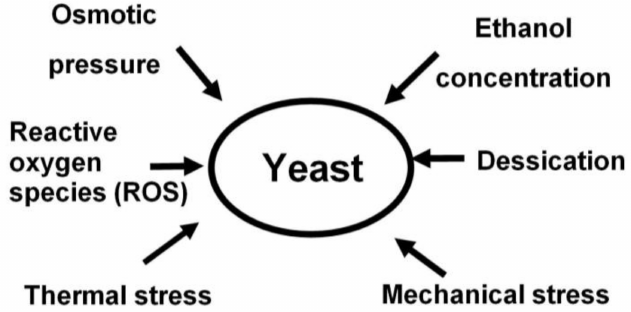
Figure 18. Factors which promote yeast stress